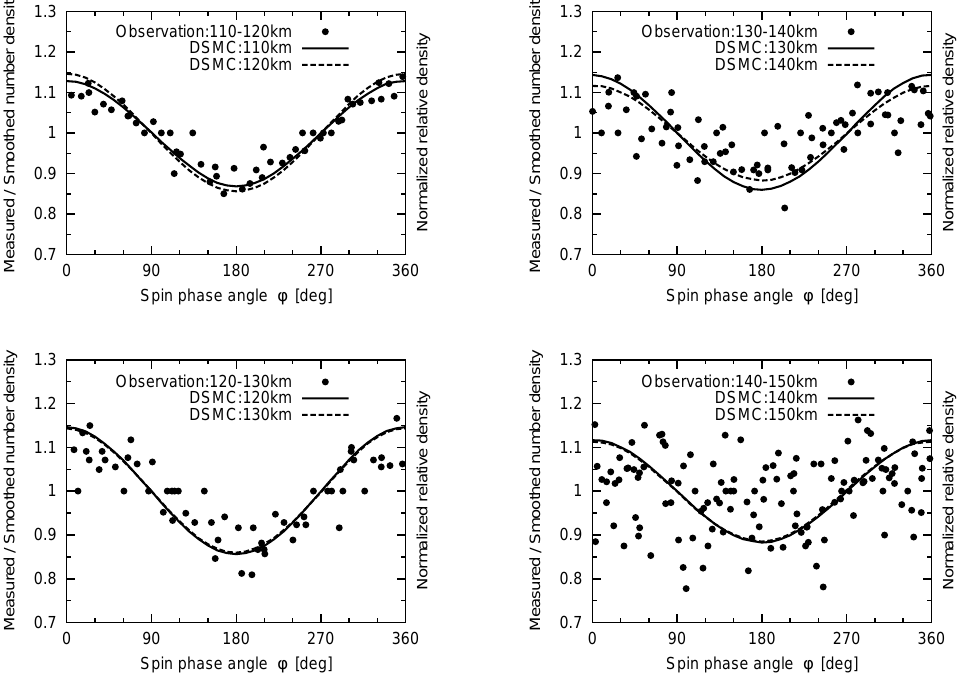
Fig. 9. Relative density changes for the observation and the DSMC results for various altitude